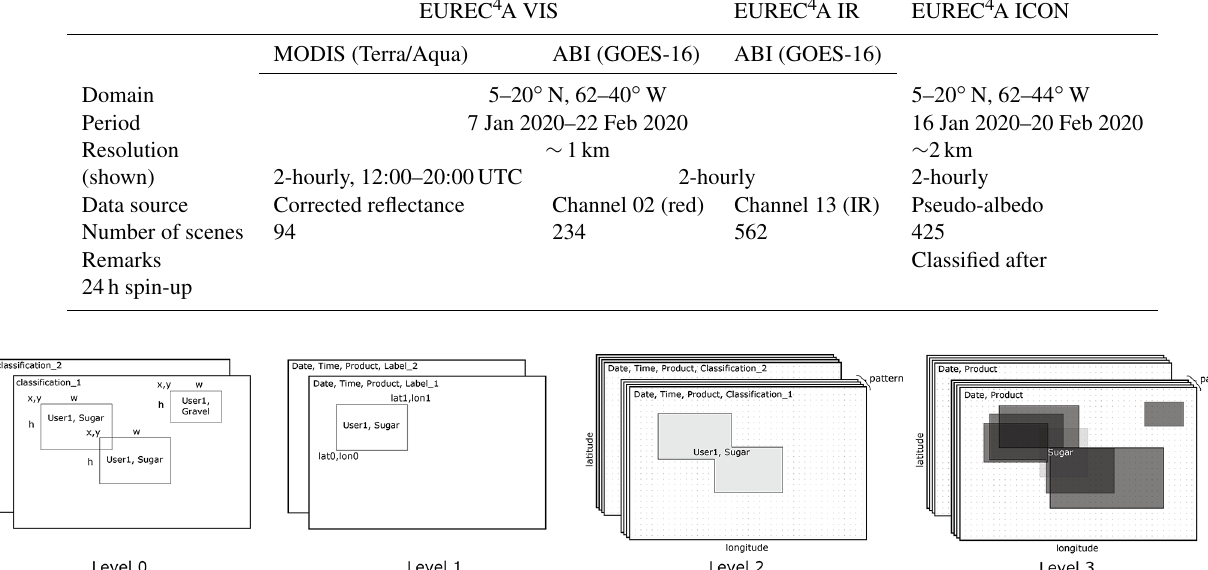
Figure 3. Overview of processing levels of the datasets including the variable names used in the respective datasets.